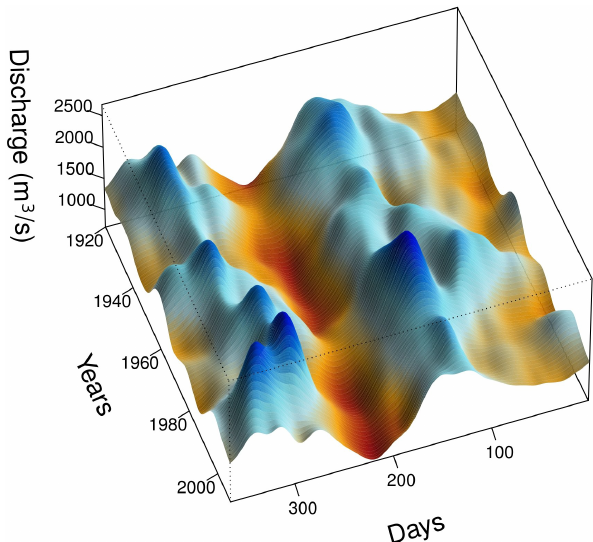
Fig. 7. 3-D representation of the Po River daily discharge time series (1920–2009). The resulting surface was smoothed by applying a moving average and a Gaussian